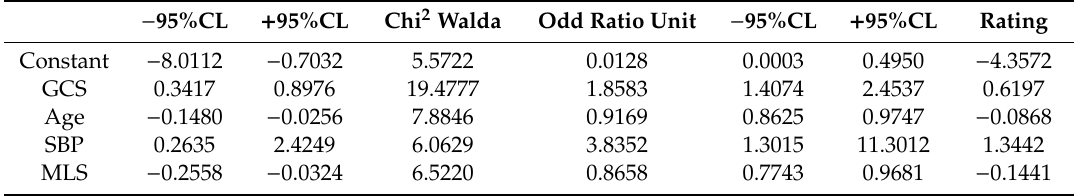
Table 2. Logistic model for the assessment of prognostic factors of the 6-month